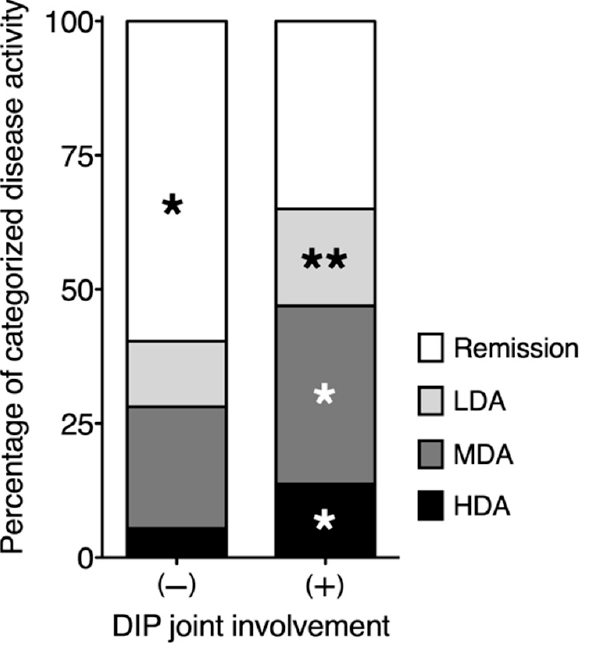
Figure 4. Distribution of disease activity for 10,038 patients with rheumatoid arthritis (RA) in the absence or presence of symptomatic distal interphalangeal (DIP) joint involvement. Symptomatic DIP joint involvement was defined by the presence of tenderness and/or swelling from the second through fifth DIP joints. The vertical axis shows the proportions of patients categorized as having remission (28-joint Disease Activity Score based on C-reactive protein [DAS28-CRP] < 2.3), low disease activity (LDA, 2.3 ≤ DAS28-CRP < 2.7), moderate disease activity (MDA, 2.7 < DAS28-CRP ≤ 4.1), and high disease activity (HDA, DAS28-CRP ≥ 4.1) in a stacked bar graph. * p < 0.01, ** p < 0.05. Table 2. Correlation coefficients among the numbers of affected distal interphalangeal (DIP) joints and clinical variables in patients with rheumatoid arthritis (RA) exhibiting DIP joint involvement. correlated with TJC, SJC, pain VAS, PGA, PhGA, DAS28-CRP, JI x , and JI y in patients with DIP joint involvement (Table 2). In addition, JI x was significantly higher than JI y in patients with RA exhibiting DIP joint involvement ( p <